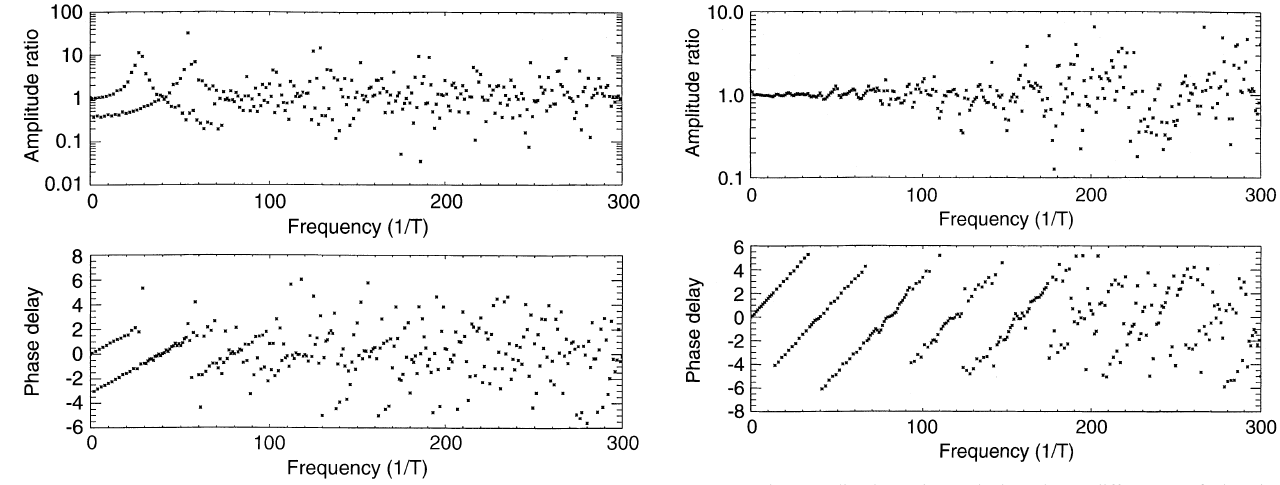
Fig. 5. The amplitude ratio/phase di(cid:128)erence of the time stationary, unwindowed datasets. The abscissa denotes the frequency in units of D f , the ordinate the amplitude ratio/phase di(cid:128)erence. The zero frequency is omitted. Frequencies higher than 300 D f are not displayed since they consist only of noise